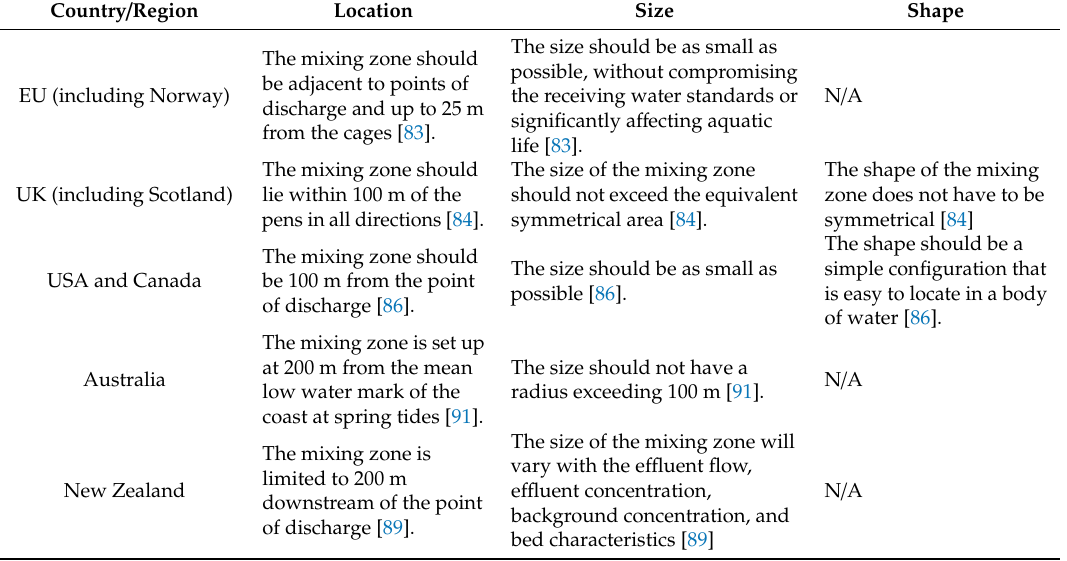
Table 2. List of the key characteristics of regulatory mixing zones (RMZs) in different countries and regions. Country / Region Location Size